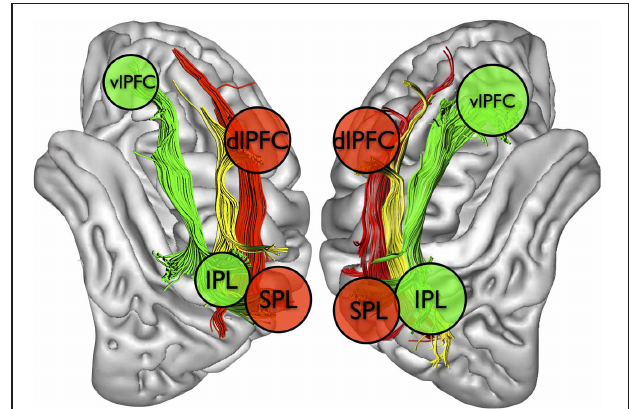
FIGURE 5 | Schematic depiction of fronto-parietal attentional networks for visuospatial processing in the two hemispheres, based on Corbetta and Shulman (2002) and Thiebaut de Schotten et al. (2011). IPL and SPL, inferior and superior parietal lobules. dlPFC and vlPFC, dorsolateral and ventrolateral prefrontal